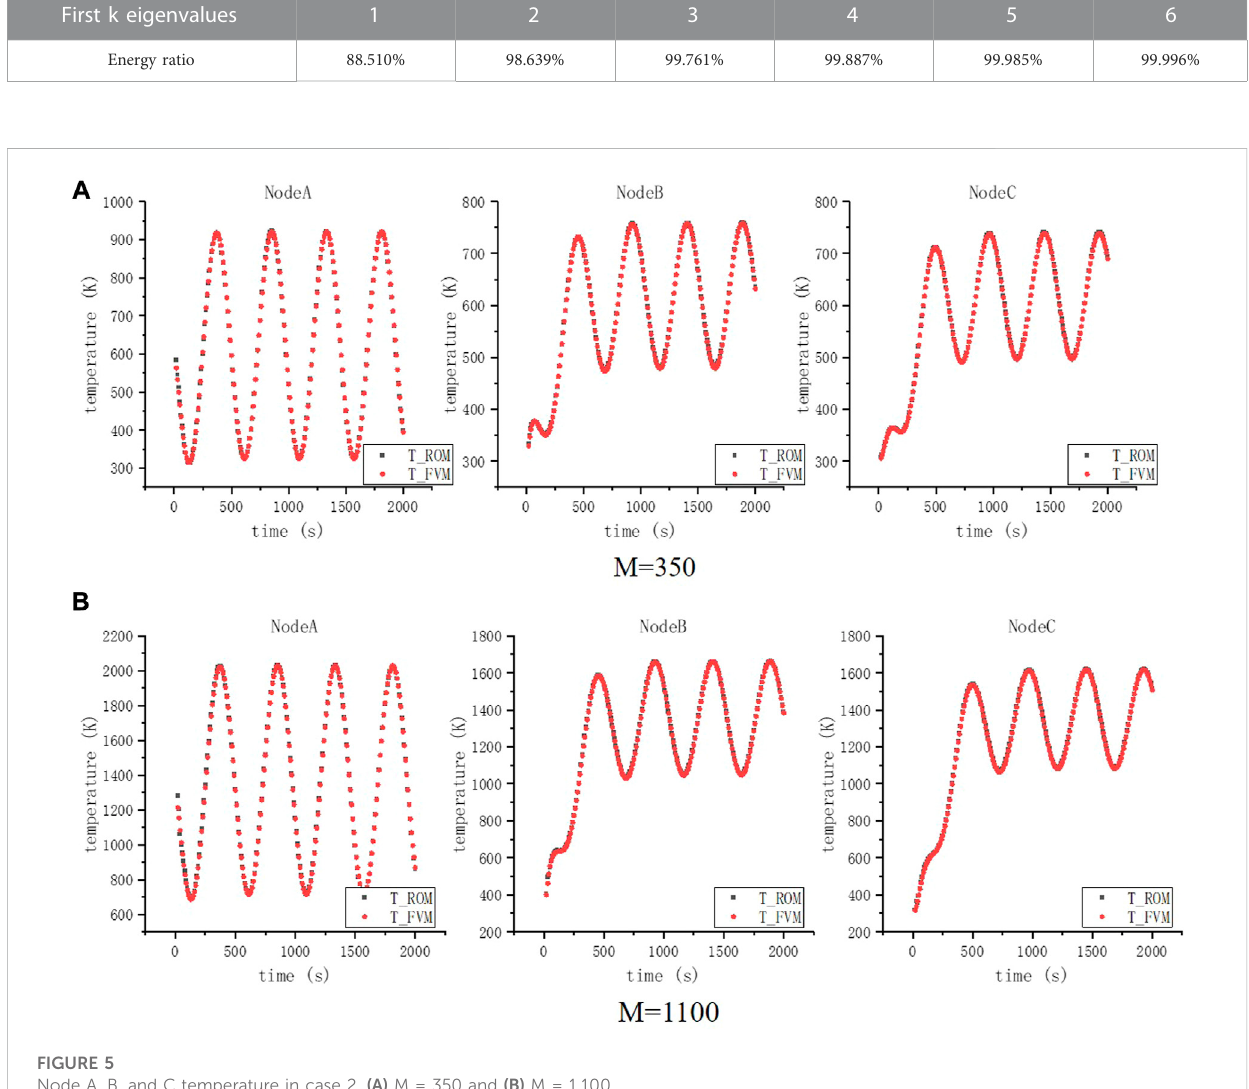
FIGURE 5 Node A, B, and C temperature in case 2. (A) M = 350 and (B) M =